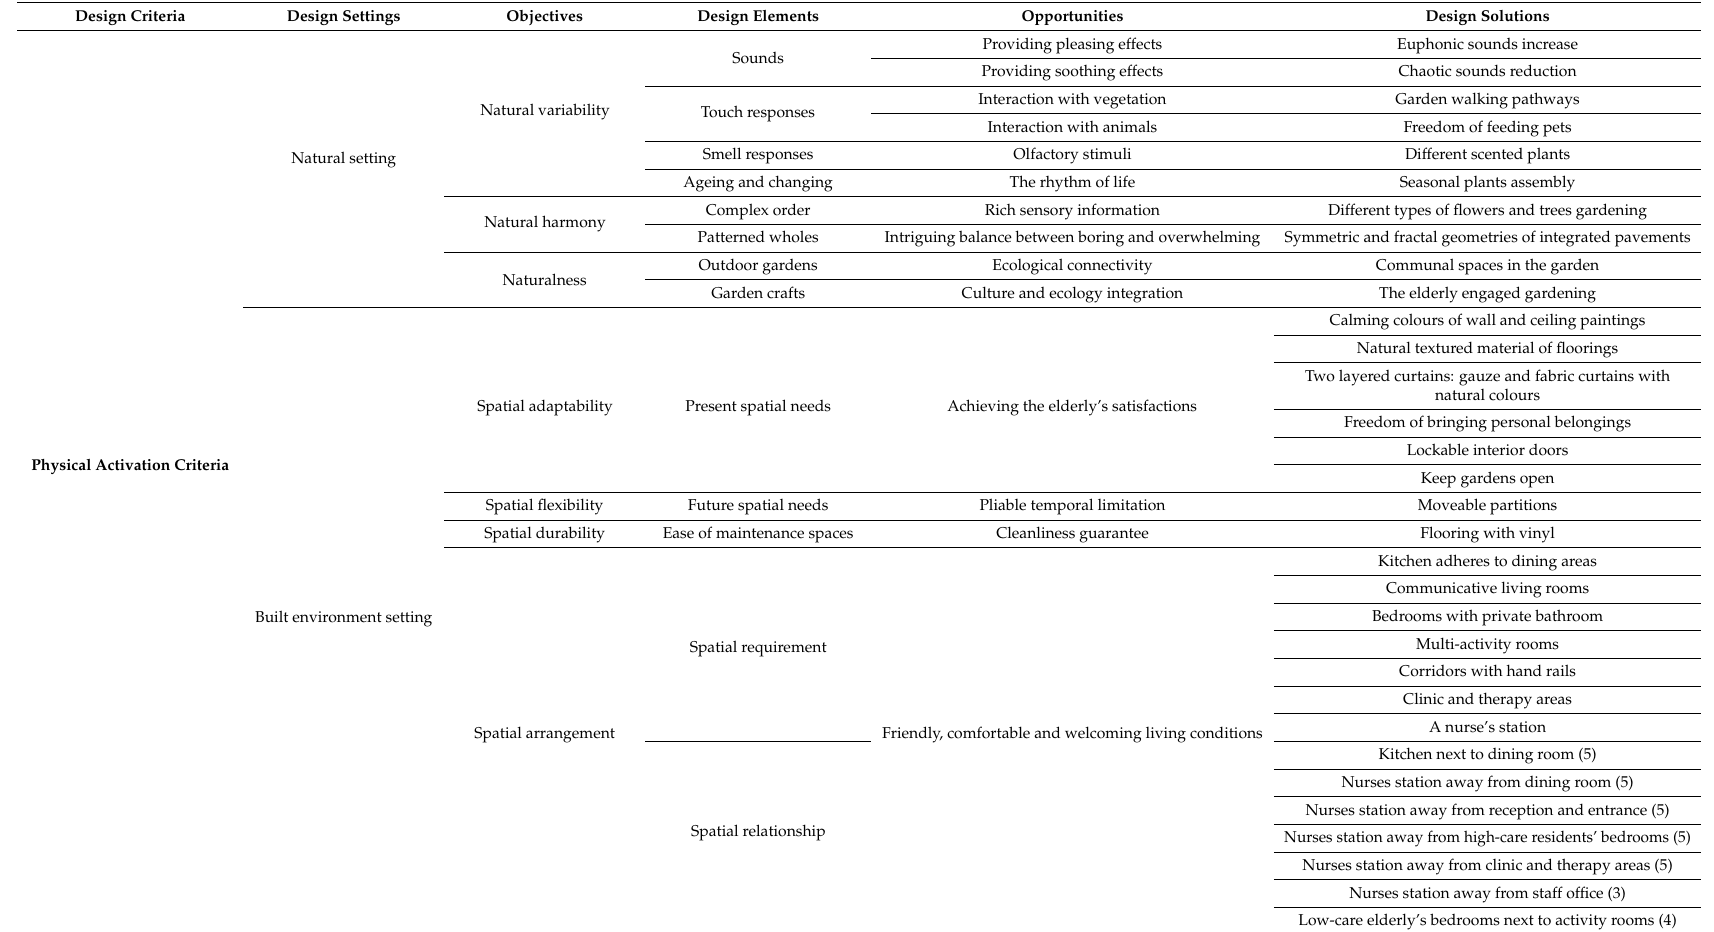
Table 2. EXD evaluation matrix enumerating potential senior users’ physical attributes and psychological perceptions towards identification of possible design solutions